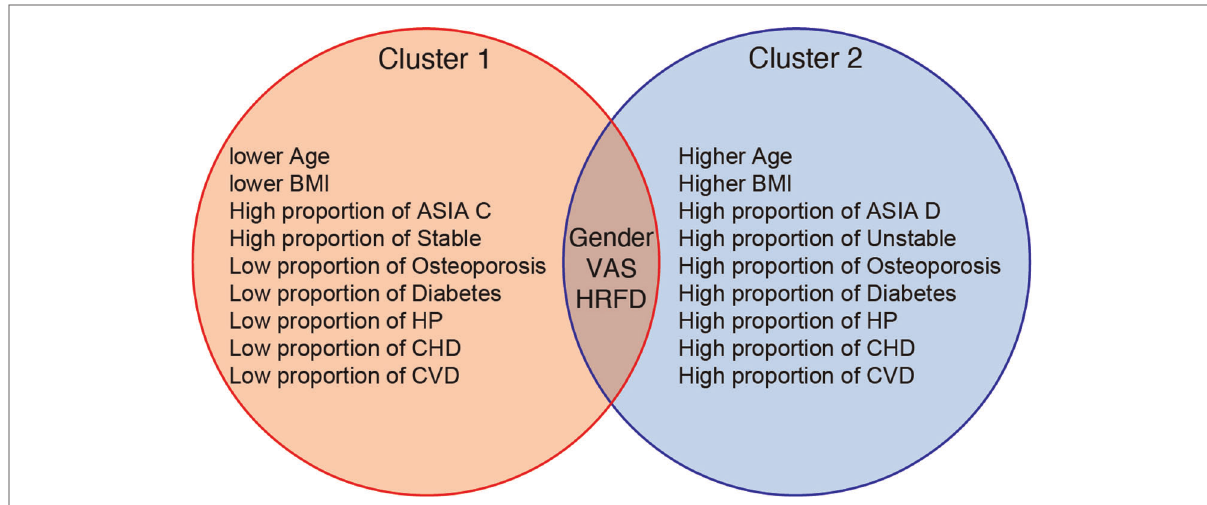
FIGURE 3 Typical clinical characteristics and features of two clusters. The blue circle represents cluster 1, more severe in condition, as opposed to the red circles. The Venn diagram summarizes the results of the unsupervised machine learning algorithm (UMLA). The results of UMLA are clinically explicable. BMI: body mass index; ASIA: American Spinal Cord Injury Association; HP: hypertension; CHD: cardiovascular heart disease; CVD: cerebrovascular disease; VAS: visual analog scale; HRFD: hepatic and renal function